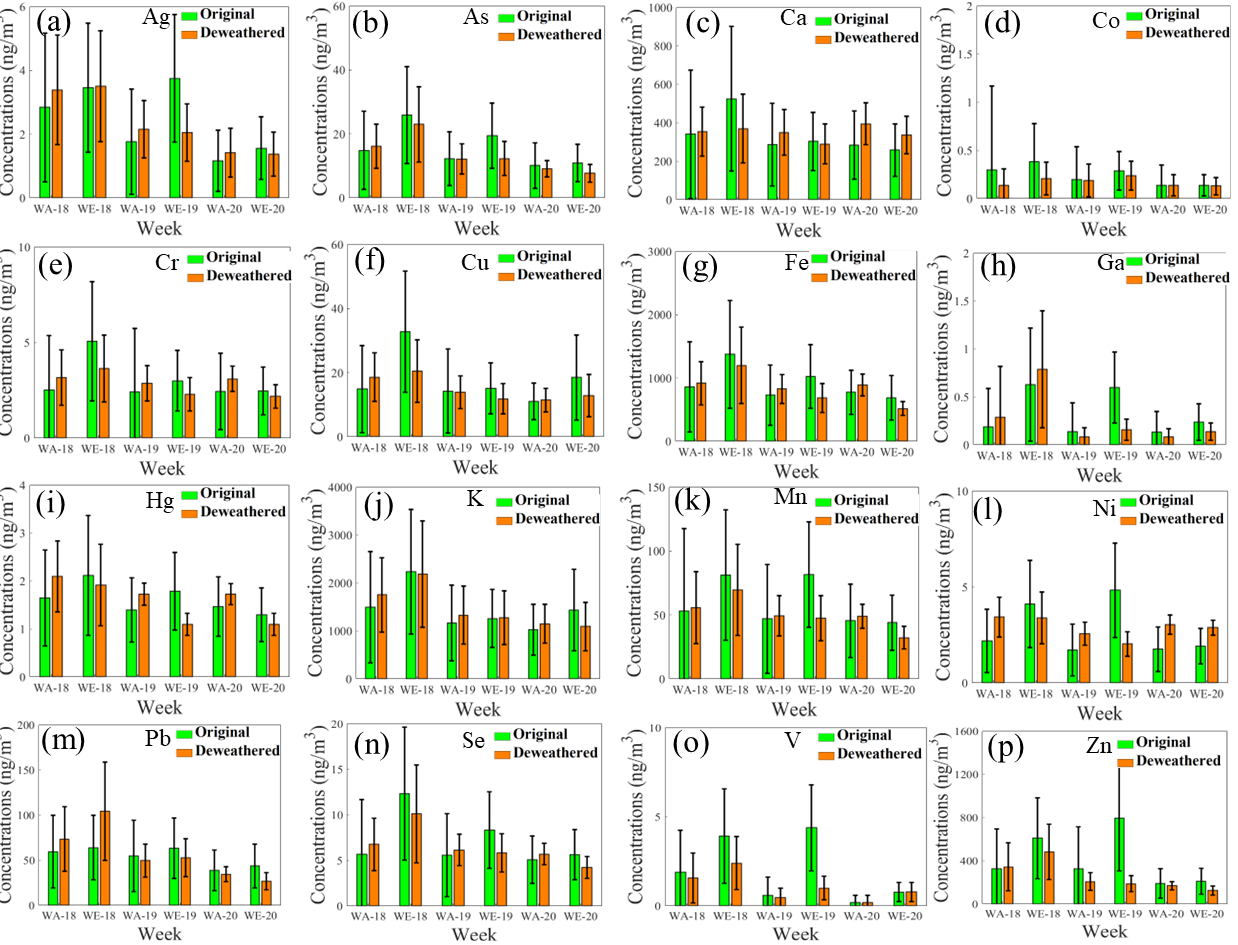
Figure 5. Weekly variations of the original (green) and deweathered (orange) element concentrations (ngm − 3 ) in PM 2 . 5 in Tangshan. The green and dark backgrounds denote the error bars of the original and deweathered elements, respectively. The bars and black lines represent mean values and associated standard deviations,